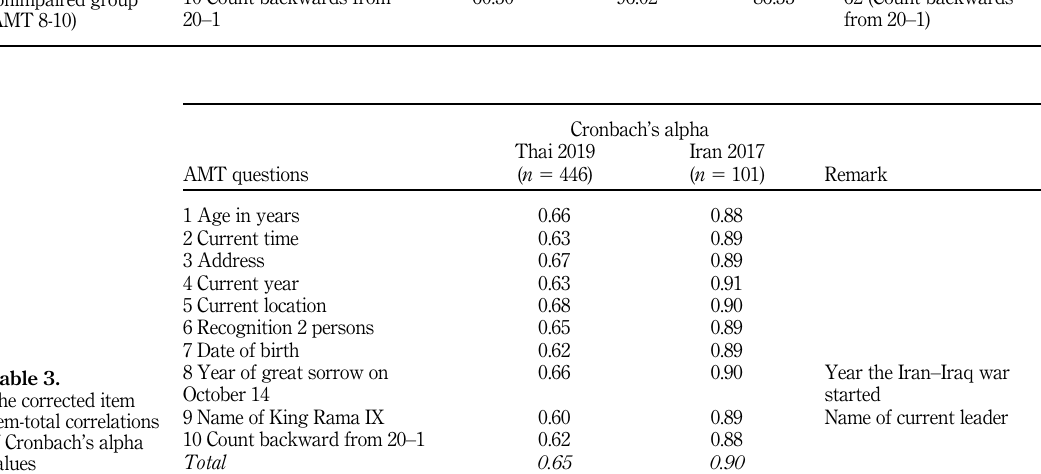
Table 2. Percent correctly answered, by item, on AMT among impaired (AMT <8) and nonimpaired group (AMT 8-10)